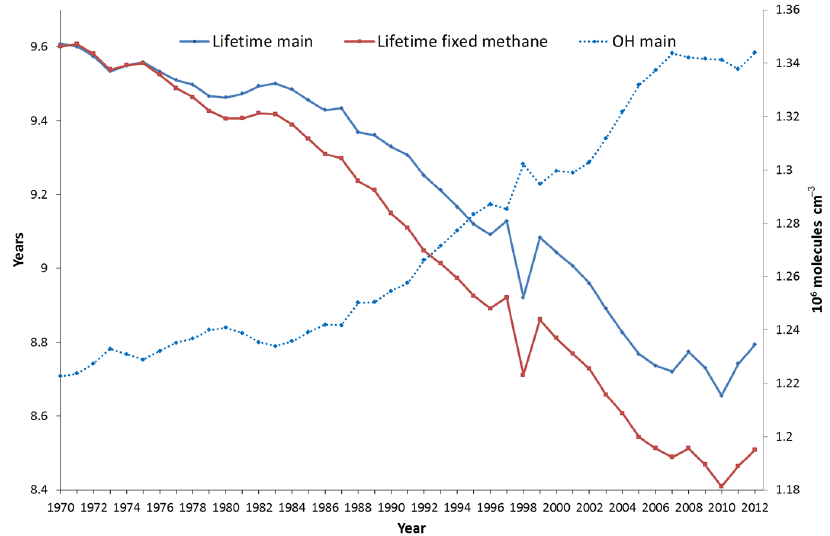
Figure 15. Evolution of yearly global average atmospheric instantaneous CH 4 lifetime in the main and fixed methane simulations (left y axis). Evolution of yearly global average atmospheric OH concentration in the main simulation (right y axis) using the reaction rate with CH 4 as averaging